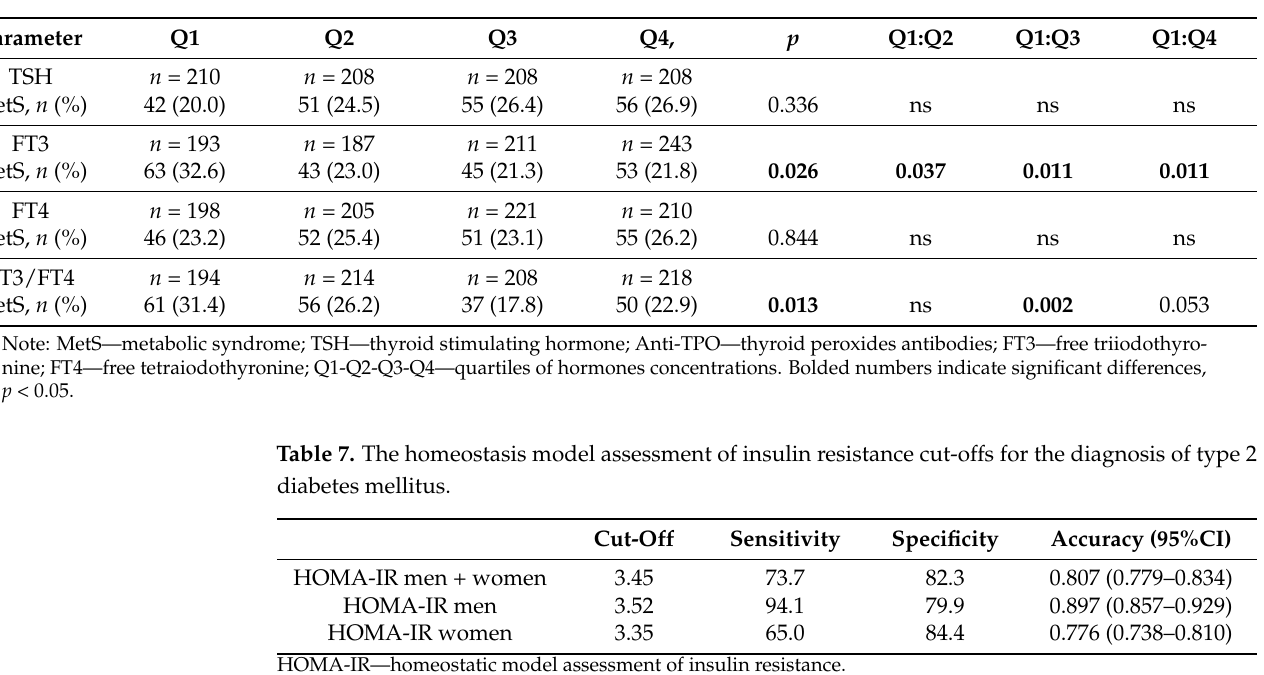
Table 6. Frequency of metabolic syndrome according to quartiles of thyroid hormone parameters.